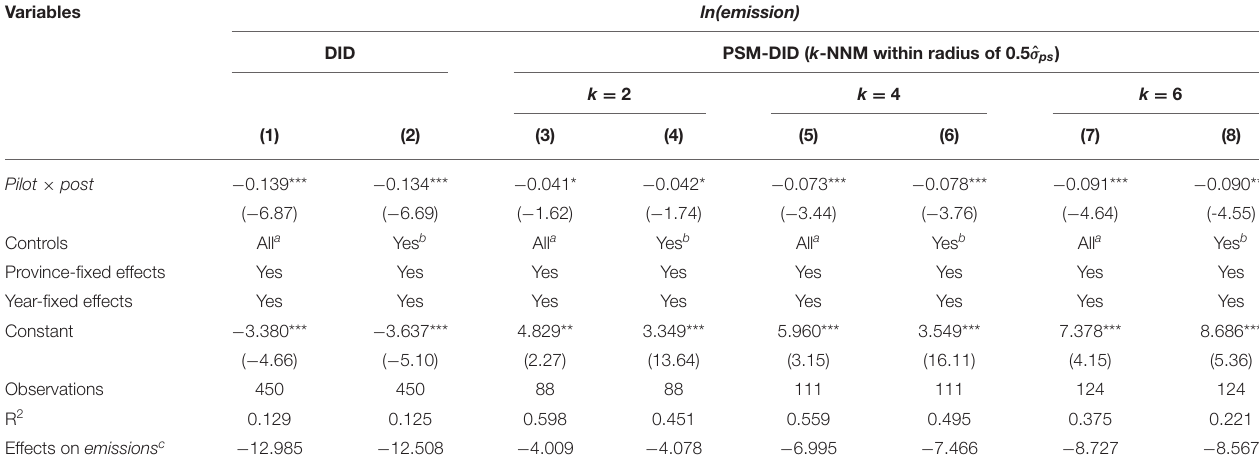
TABLE 6 | PSM-DID results.